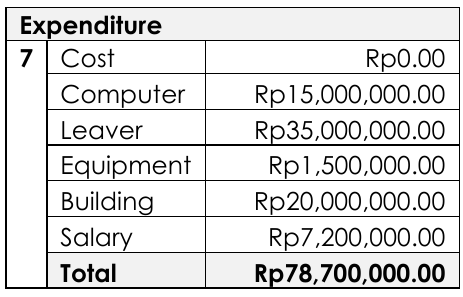
Table 7. Cost by Adding One Additional Server